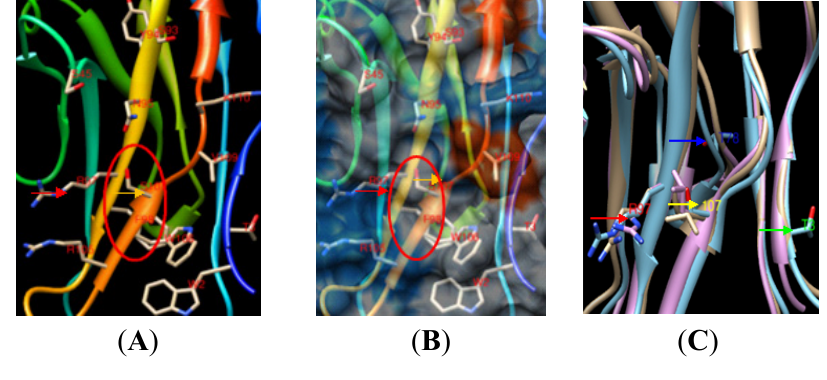
Figure 2. Skeleton model and surface model of pSN binding with PRRSV sialic acid. ( A ) In the pSN skeleton model, amino acids W2, Y44, S45, R105, W106, S107 (yellow arrow) and R97 (red arrow) formed an obvious cavity (red circle) to bind to PRRSV sialic acid; ( B ) In the pSN surface model, amino acids R97 (red arrow) and S107 (yellow arrow) formed a space for pSN to bind to PRRSV sialic acid (red circle); The blue surface indicates hydrophilic residues, and the red surface indicates hydrophobic residues; and ( C ) In skeleton model, superimposition of no-ligand pSN, mSN and cSN structures also showed that R97 (red arrow) and 107 (yellow arrow, including S107 in pSN, V107 in cSN and L107 in mSN) were important amino acids for binding, while the other amino acids including T3 (green arrow),T78 (blue arrow) were far away from R97, making it difficult